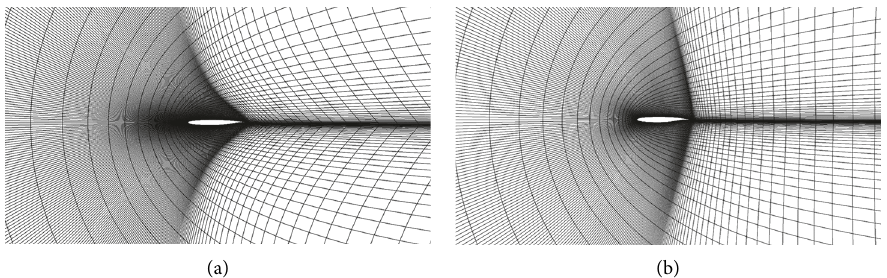
Figure 7: Far-field of Euler meshes optimized without curvature functions. (a) Optimized without orthogonality functions. (b) Optimized with orthogonality functions.